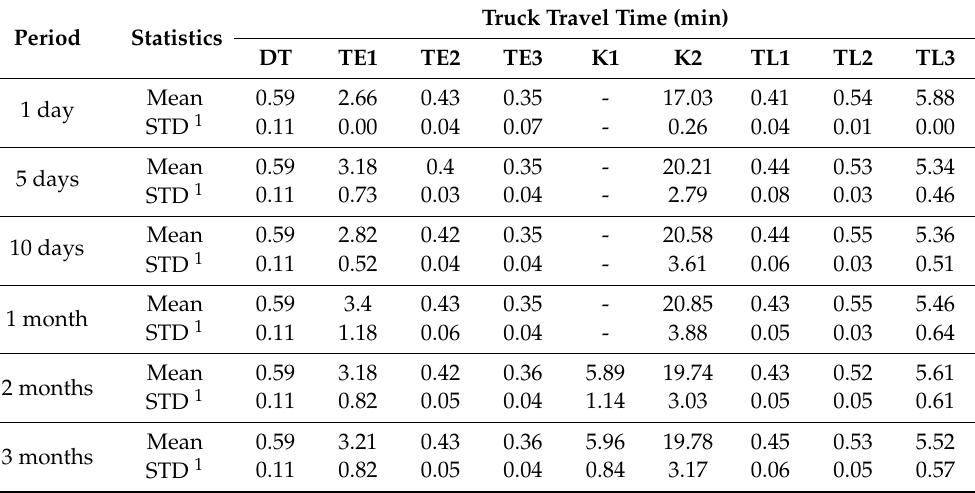
Table8. Resultsofmeasuringtrucktraveltimewhenthestatisticaldatacollectionperiodissetdi ff